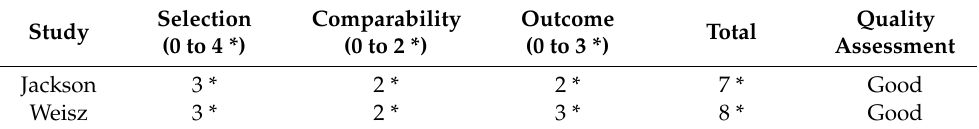
Figure 2. Risk-of-bias summary for the RCTs. Zhang 2015 [9]; Gu 2016 [14]; Nicolau 2015 [15]; Gargiulo 2016 [16]; Moayeddi 2019 [17]; Sugano 2014 [18]; Vaduganathan 2016 [19]; Whellan 2014 [23]. Table 2. Newcastle–Ottawa scale scores for the observational studies.